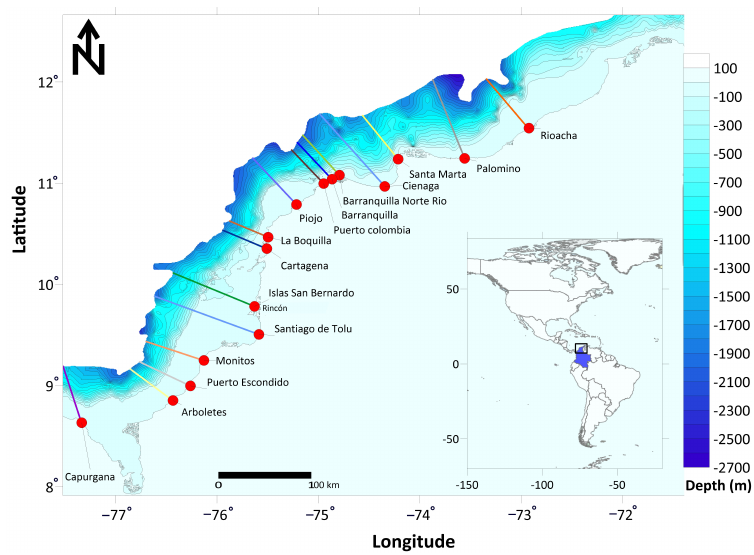
Figure 5. Location of profiles of 16 points in the Colombian